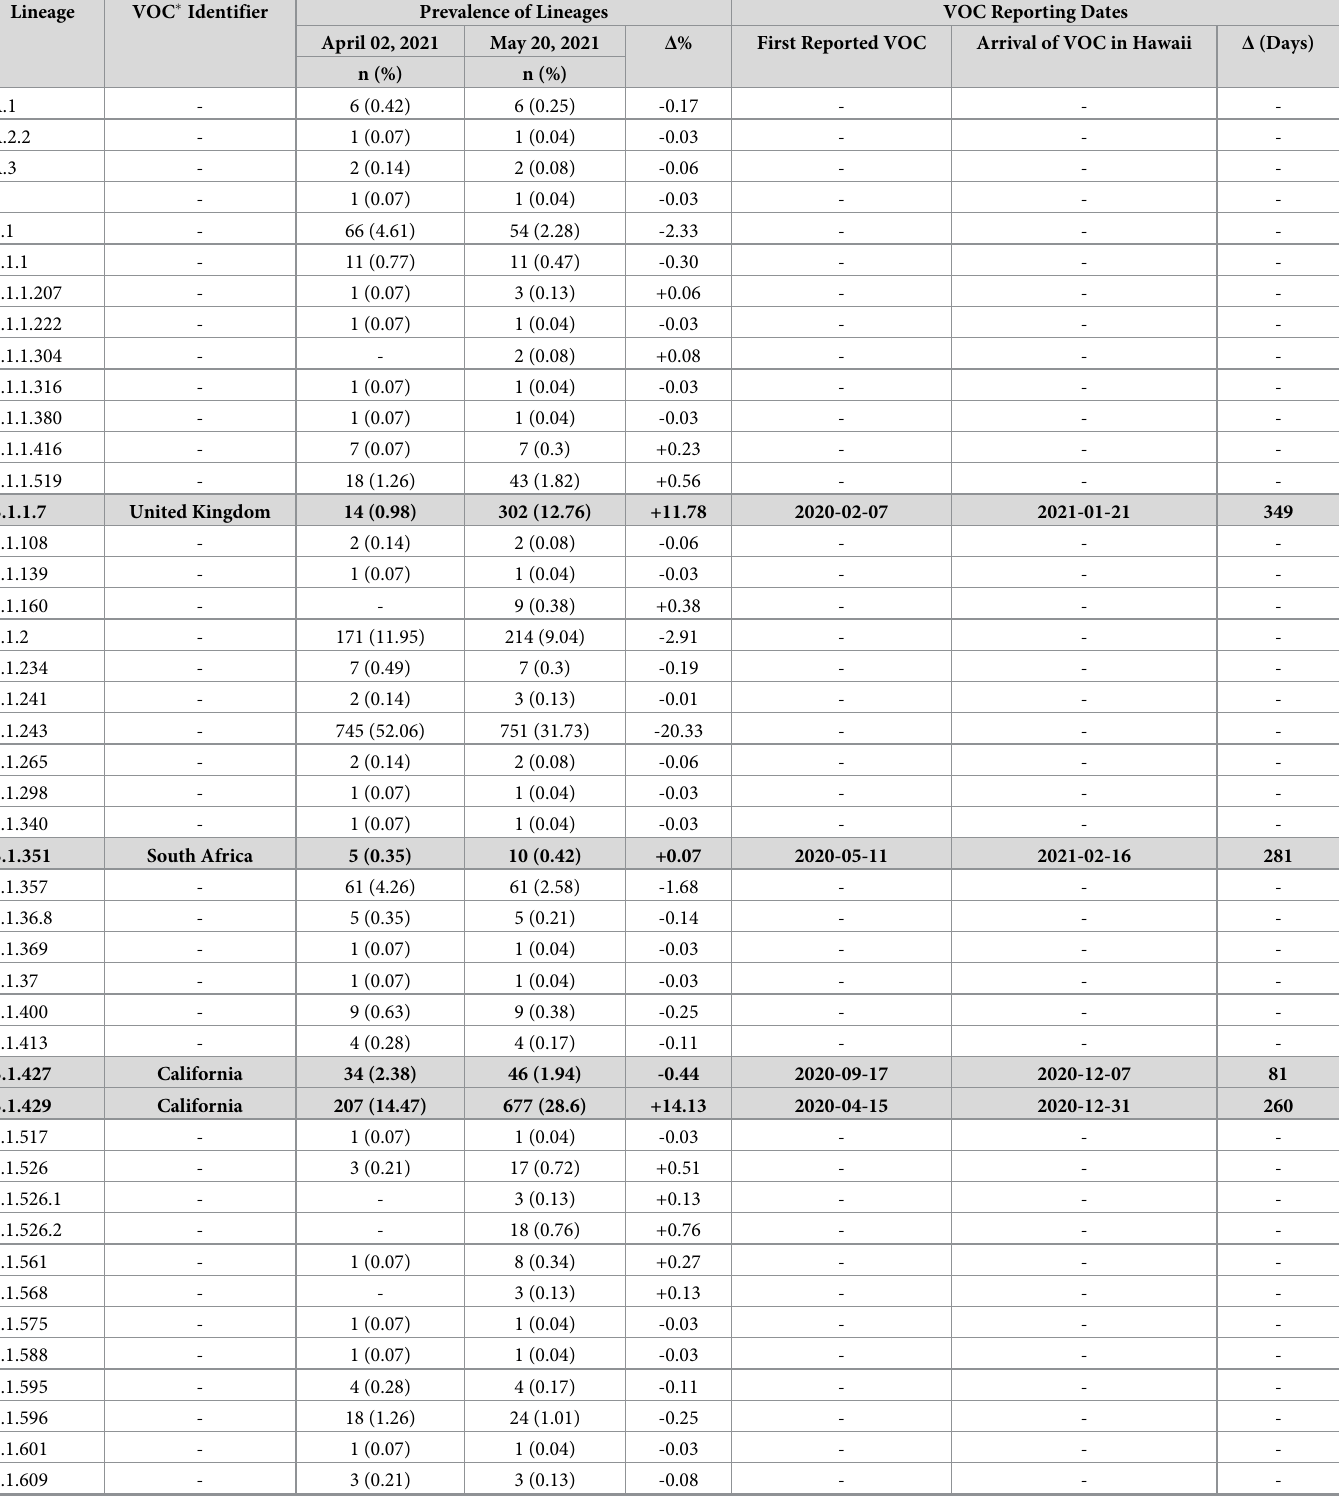
Table 1. SARS-CoV-2 lineage prevalence in Hawai’i as of April 02, 2021 and May 20,